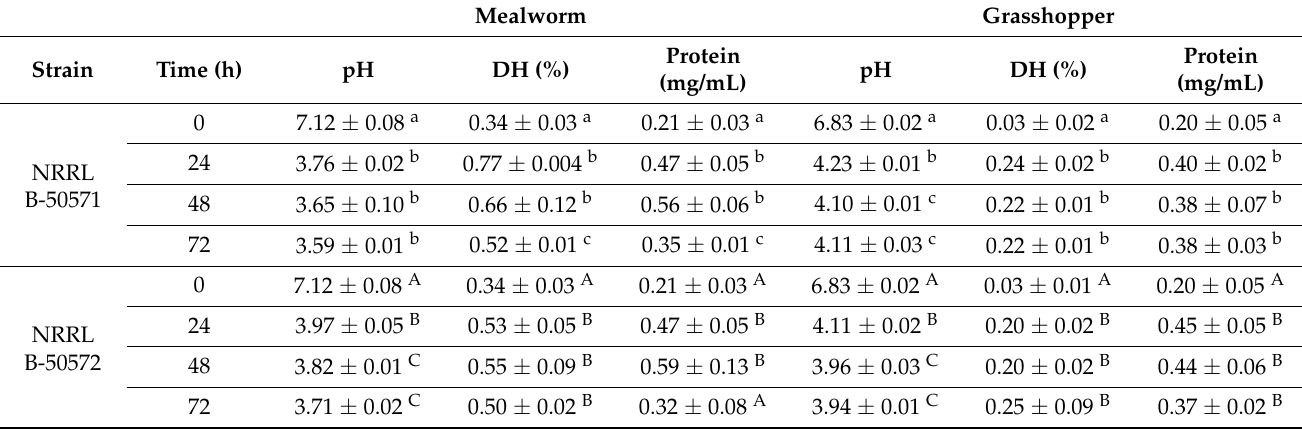
Table 3. The parameters evaluated during the fermentation process of both insect flours. Mealworm